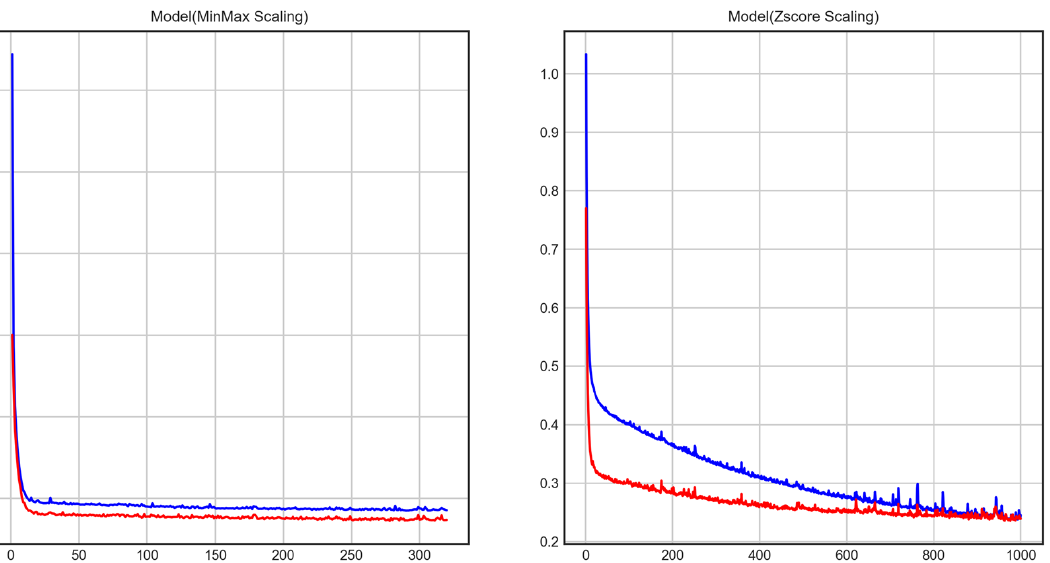
Table 5. Mean and Standard deviation of R-square. Case